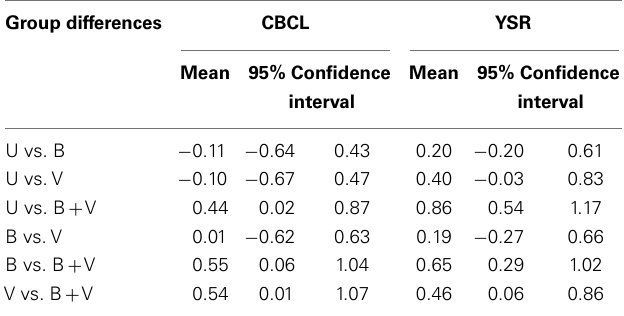
Table 6 | Comparison of total problems according to different